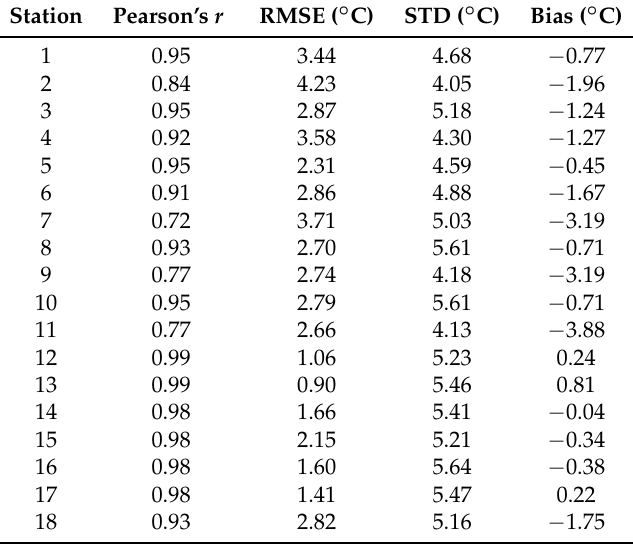
Table 5. Statistical comparison between model results and in situ measured water temperature in vertical profiles (s/y Oceania).